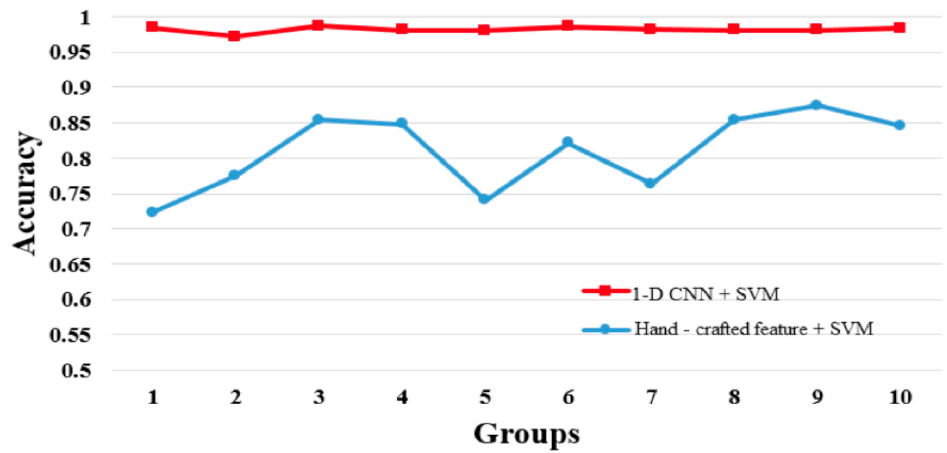
Figure 9. The ten-fold-cross evaluation for the proposed method (1-D convolutional neural network (CNN) + support vector machine (SVM)) and the conventional machine learning method (hand-crafted feature + SVM) from [132], Copyright 2019, IEEE Xplore.